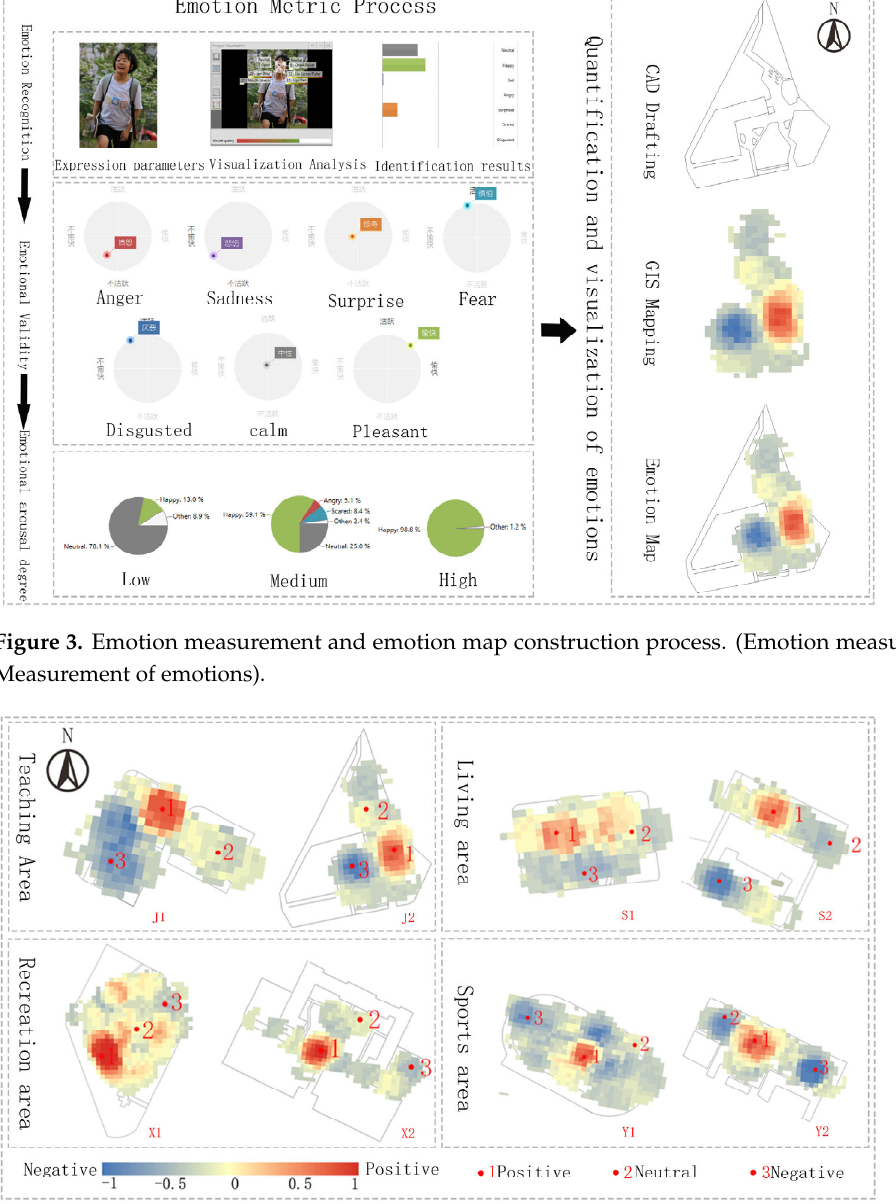
Figure 4 . Mood map and mood marker points for each division .